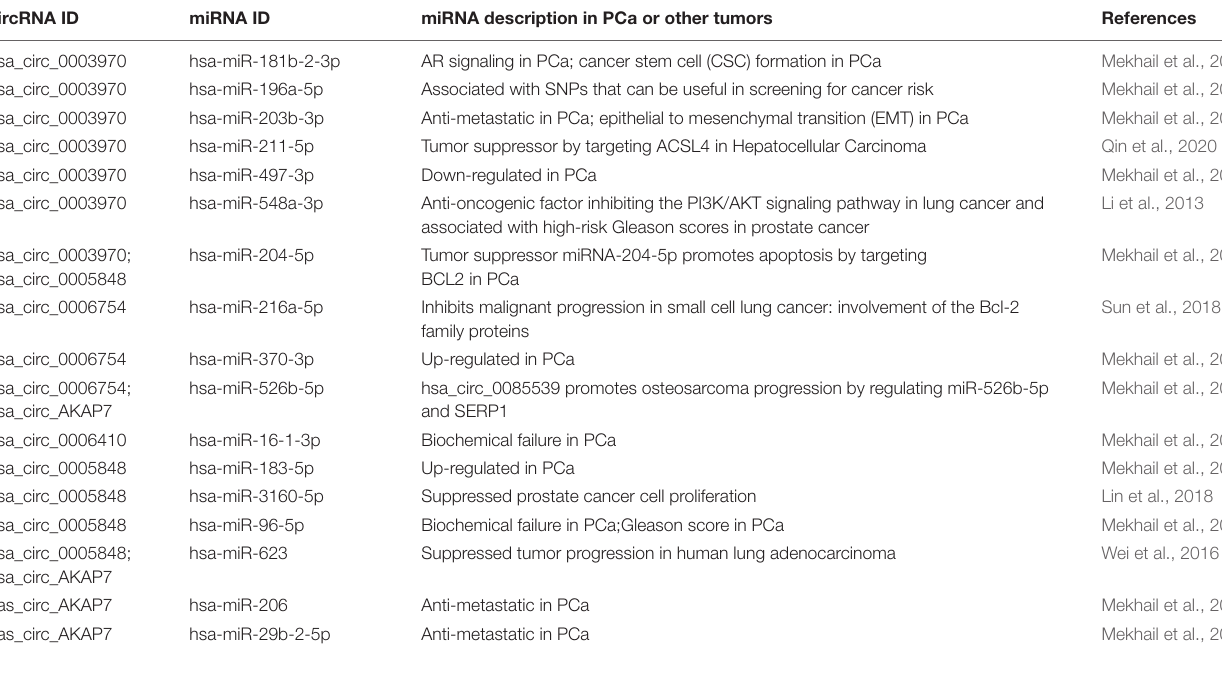
TABLE 2 | The literature mining of circRNAs related